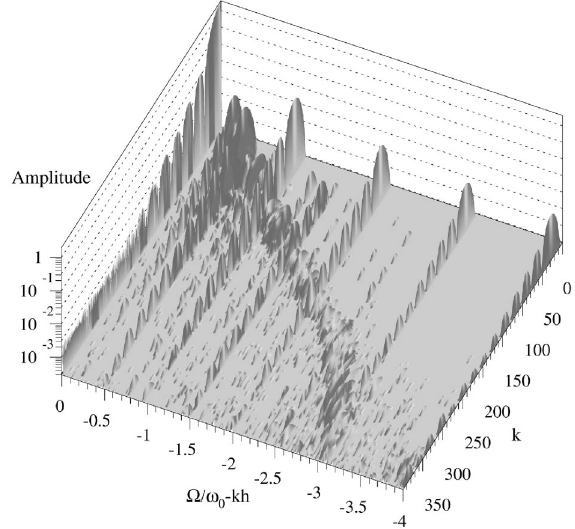
FIG. 10. Frequency spectrum of the monopole moment on the way to the maximum momentum spread at 116.4 ms during the longitudinal instability. For the sake of the clear sight of the main signals, the spectrum normalized by the dc component is cut away below 3 (cid:11) 10 (cid:3) 4